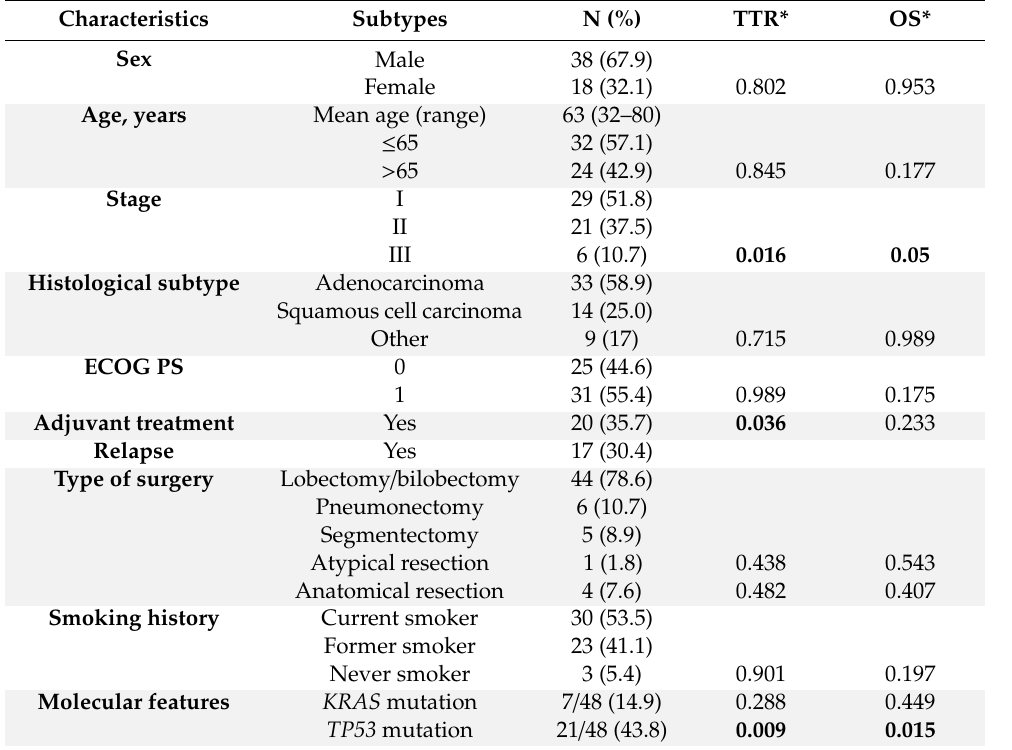
Table 1. Main clinical characteristics of the 56 patients and univariate p -values (log-rank test) for time to relapse (TTR) and overall survival